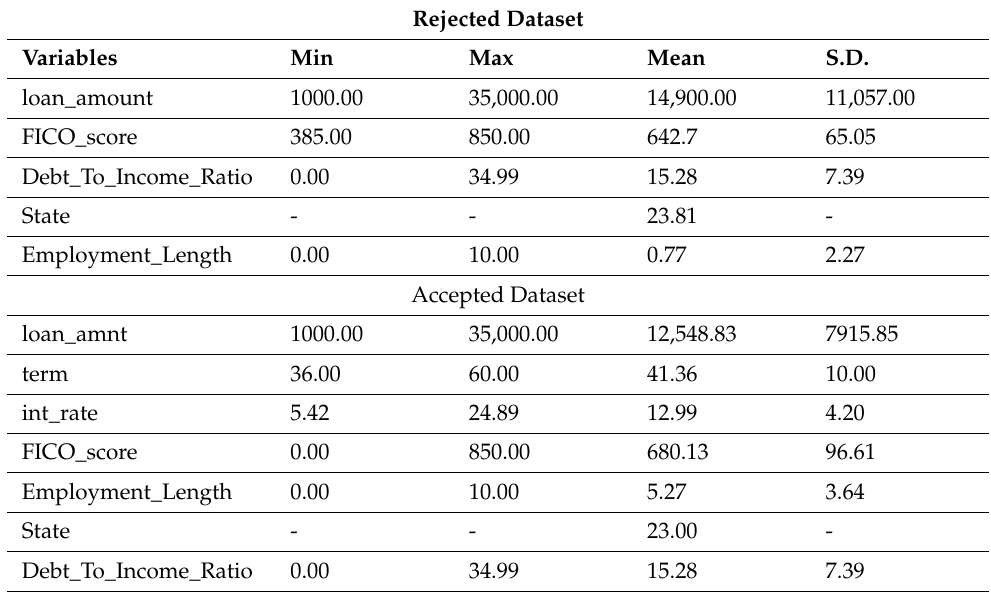
Table 3. Descriptive statistics of the Lending Club